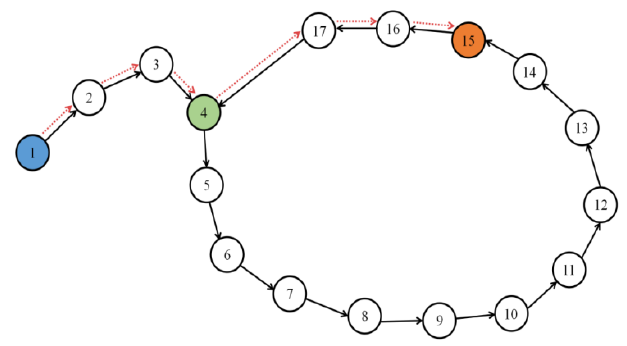
Figure 6. Path planning schematic of topological map.